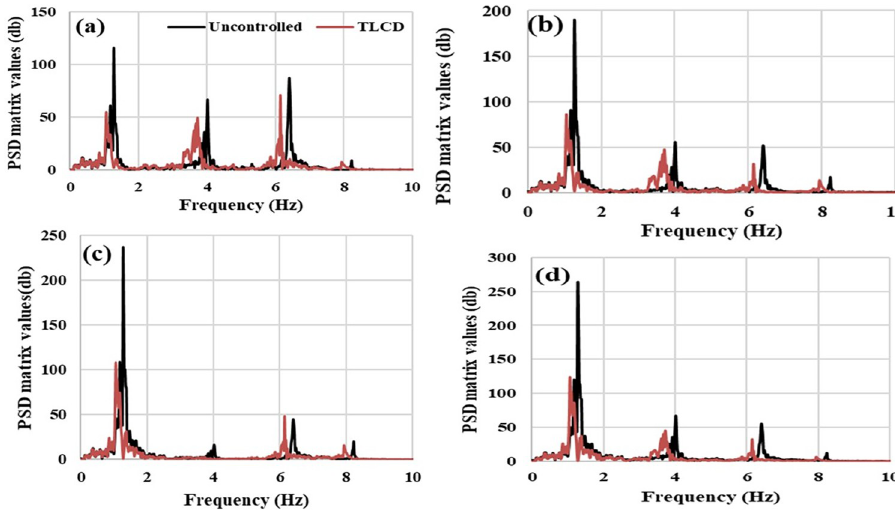
Fig 14. Acceleration Power Spectral Density (PSD) responses of the MDOF structure equipped with and without TLCD at seismic loading, (a) Storey Level -01, (b) Storey Level -02, (c) Storey Level -03, (d) Storey Level -04.